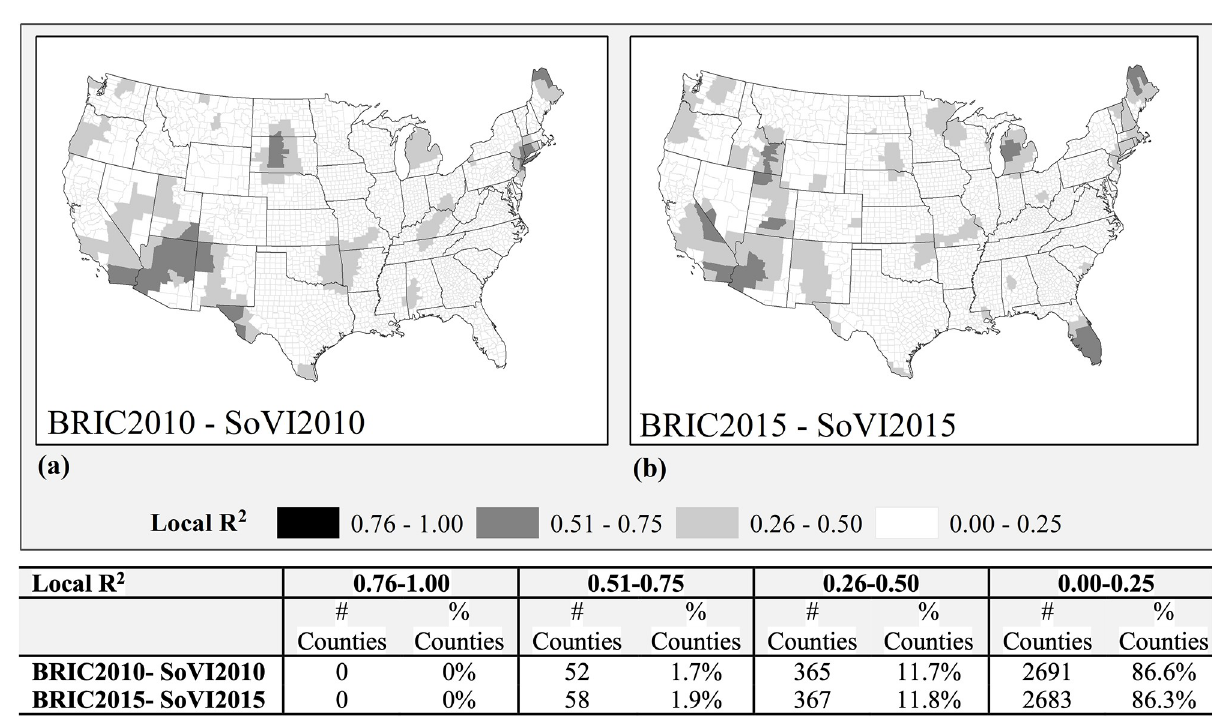
Fig 2. Local R 2 from GWR results for BRIC and SoVI (a) 2010, (b) 2015. County and state boundaries are retrieved from the U.S. Census Bureau